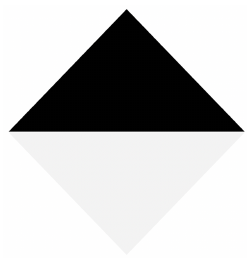
Figure 8. Proposed board for calibration between 2D and 3D data. Since the signal intensity measured by the LiDAR in each 3D point varies according 231 to the material and color of the surface where the LiDAR’s lasers bounce, the selected 232 colors for the calibration board are white and black. When the lasers bounce off on a 233 white colored surface, the LiDAR receives signals with a higher intensity, when compared 234 to the case of a black surface. This difference in intensity levels at the 3D points can later 235 be used to verify the calibration between the LiDAR and the multispectral camera. 236